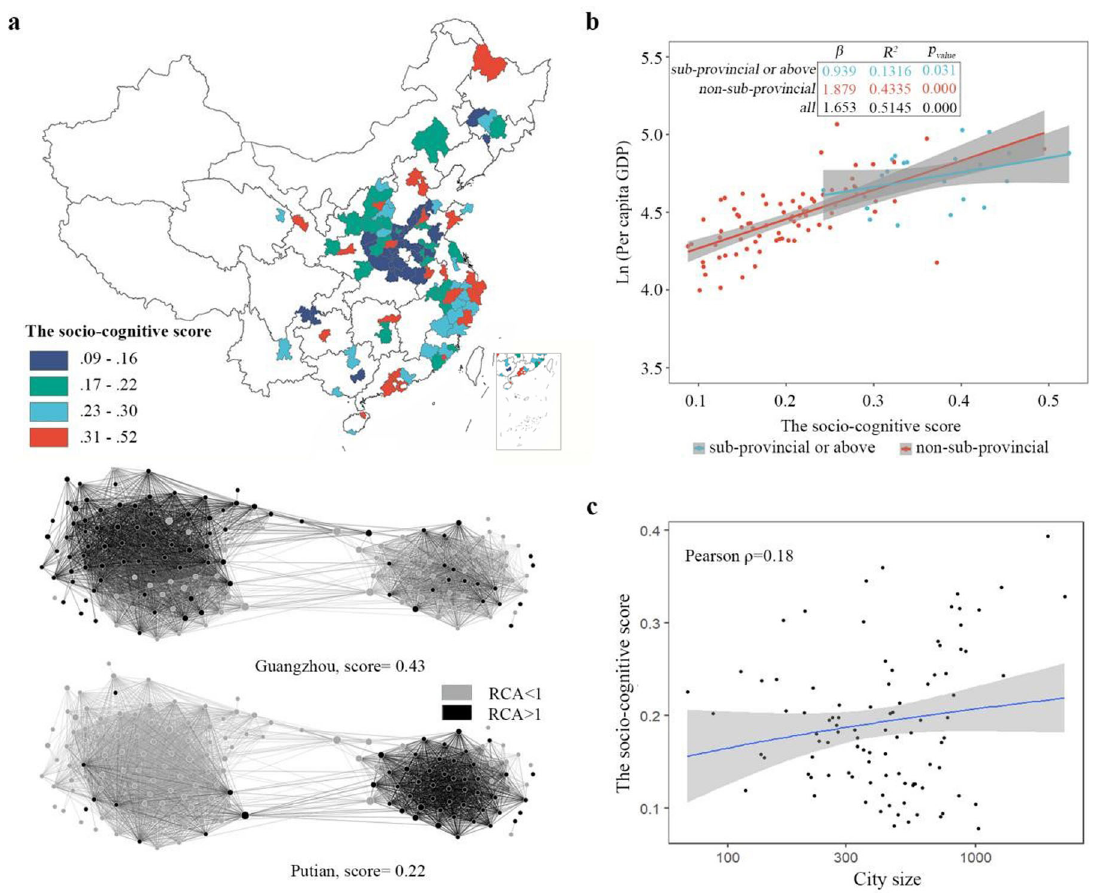
Fig. 5 City skill pro fi le. a The skills that are effectively used by a city are highlighted in the skill space. Two cities representing high- and low-level cognitive scores were selected as examples. b Strong correlation is found between the GDP per capita and the city cognitive scores. Cities of higher administrative power, so called “ sub-provincial or above ” cities, highlighted in blue, tend to have greater cognitive scores and GDP per capita than their peers. c The scatter diagram shows a weak relationship between city ’ s cognitive scores and its population